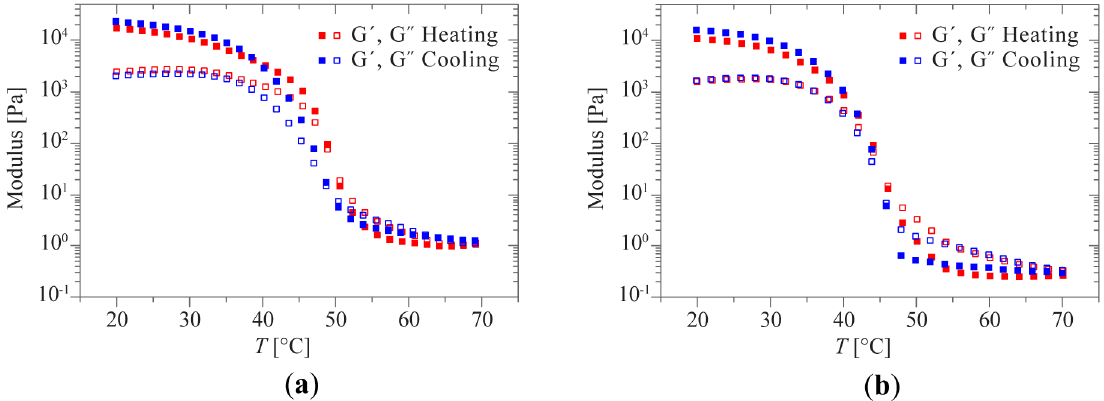
Figure 8. Temperature dependence of G ′ and G ″ for 10 wt % samples of 1a ( a ) and 1b ( b ), measured at 10% strain amplitude, an angular frequency of 1 Hz and a heating and cooling rate of 1 °C/min.